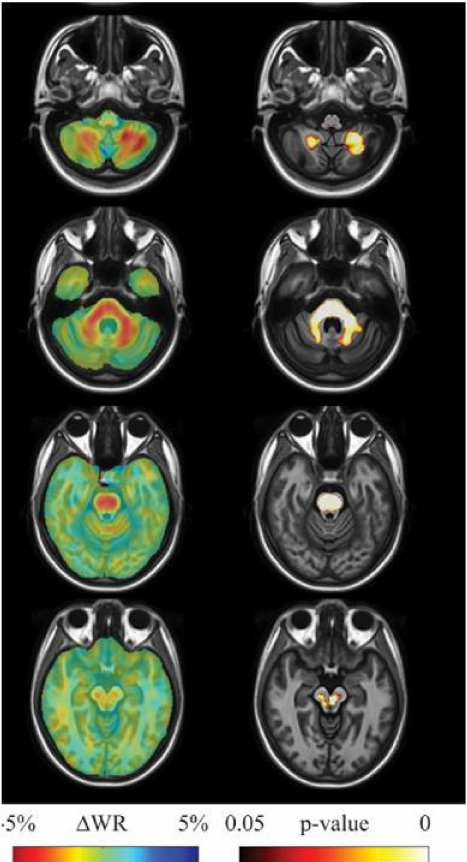
Figure 5. Results of longitudinal between group (10 SCA2 vs. 16 healthy controls, each examined with a mean interval of 3.3 years between initial and follow-up MRI) tensor-based morphometry analysis. Left panel: sample of axial views of the di ff erence in average longitudinal warp rate (WR) maps between SCA2 patients and healthy controls, where red indicates local thinning and blue indicates local enlargement. Right panel: voxel-wise threshold-free cluster enhancement corrected p -value maps at the same levels, testing the null hypothesis of zero di ff erences in WR between SCA2 patients and healthy controls. Highlighted clusters indicate significantly ( p < 0.05) accelerated volume loss in SCA2 patients when compared to healthy controls. SCA2 patients exhibit significantly accelerated volume loss in the midbrain (substantia nigra and medial lemniscus, bilaterally, right lateral lemniscus and central region corresponding to decussation of the superior cerebellar peduncles), the entire basis pontis, the middle cerebellar peduncles and posterior medulla corresponding to the gracilis and cuneatus tracts and nuclei. The cerebellum shows accelerated loss of the white matter in the hemispheric and peridentate regions and of the gray matter in the cerebellar cortex of the inferior portions of the cerebellar hemisphers. Reproduced from Mascalchi M, Diciotti S, Giannelli M, Ginestroni A, Soricelli A, Nicolai E, Aiello M, Tessa C, Galli L, Dotti MT, et al.: Progression of brain atrophy in SCA2. A longitudinal TBM study.PLoS One25; 9(2):e89410,